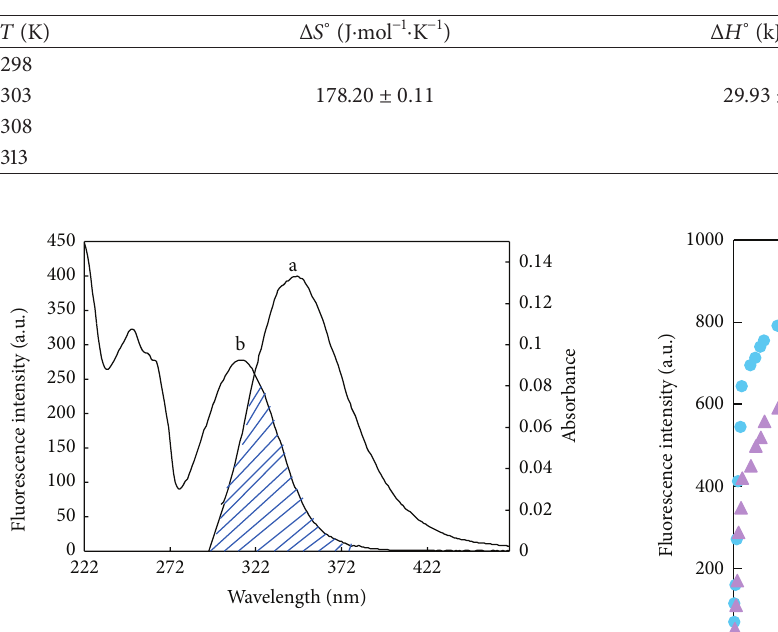
Figure 6: The overlap of the fluorescence spectrum of HSA (a) and the absorption spectrum of isoimperatorin (b) when [ HSA ] = [ isoimperatorin ] = 10𝜇 M. The enzyme was excited at 295 nm.